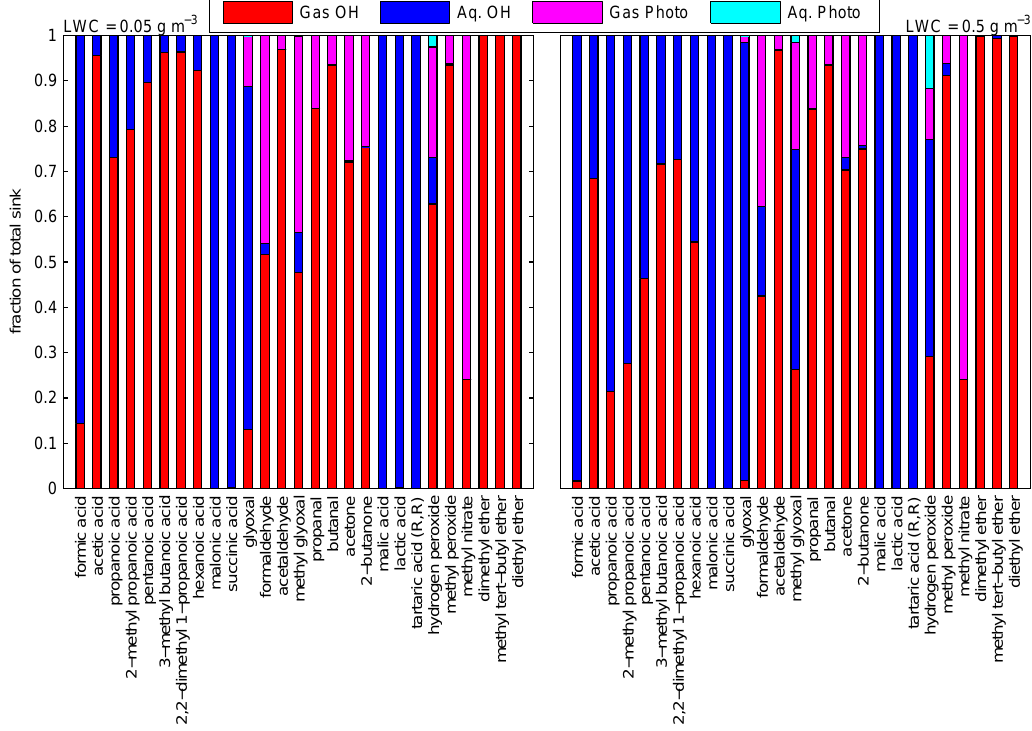
Fig. 10. Estimated magnitudes of each of the 4 chemical sinks investigated for compounds with sufficient published data. All acids are assumed to be in cloud or fog droplets at a pH = 6. Calculations were performed with a solar zenith angle of 20 ◦ . The right panel details selected species in a parcel with a LWC = 0.5gm − 3 at 298K and represents the upper limit for the contribution of aqueous processes in all situations at 298K. The left panel shows the contribution of each of the four sinks in an air parcel with a more realistic LWC = 0.05gm − 3 at 298K. The contributions of aqueous processes in this panel are also an upper estimate for the selected